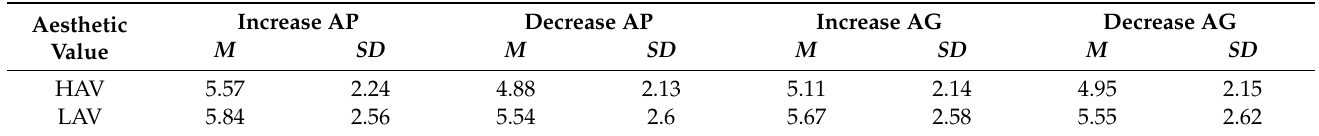
Table 3. Allocation amounts (mean ± SD): Increase AP signifies when participants received the message of increasing anticipated pride (“I would feel pride in protecting the environment”), and Decrease AP signifies when participants received a message of decreasing anticipated pride (“I wouldn’t feel pride in polluting the environment”). Similarly, for Increase AG, the message was “I would feel guilty about polluting the environment”, and for Decrease AG, the message was “I wouldn’t feel guilty about protecting the